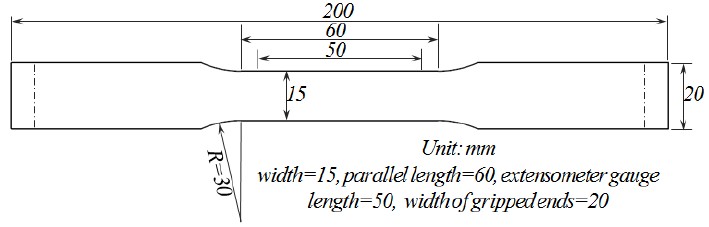
Figure 2. Detailed dimensions of tensile test specimen used in the study.